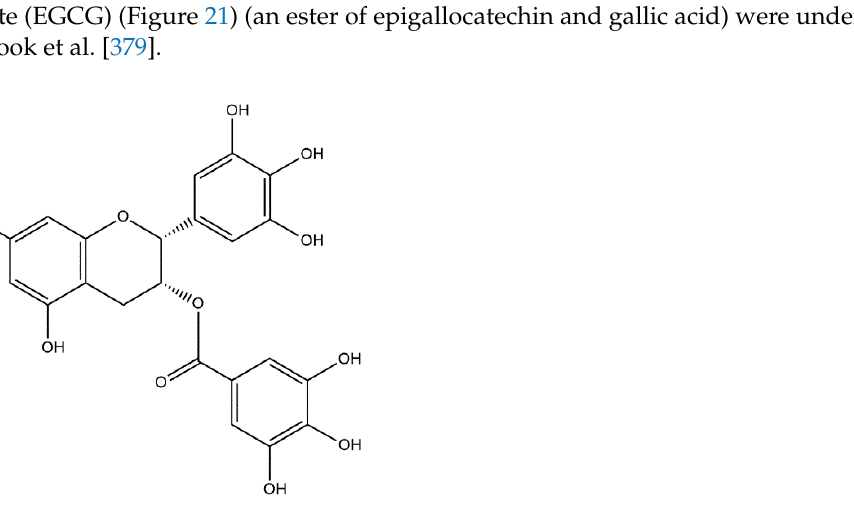
Figure 21. Schematic representation of the chemical structure of epigallocatechin gallate